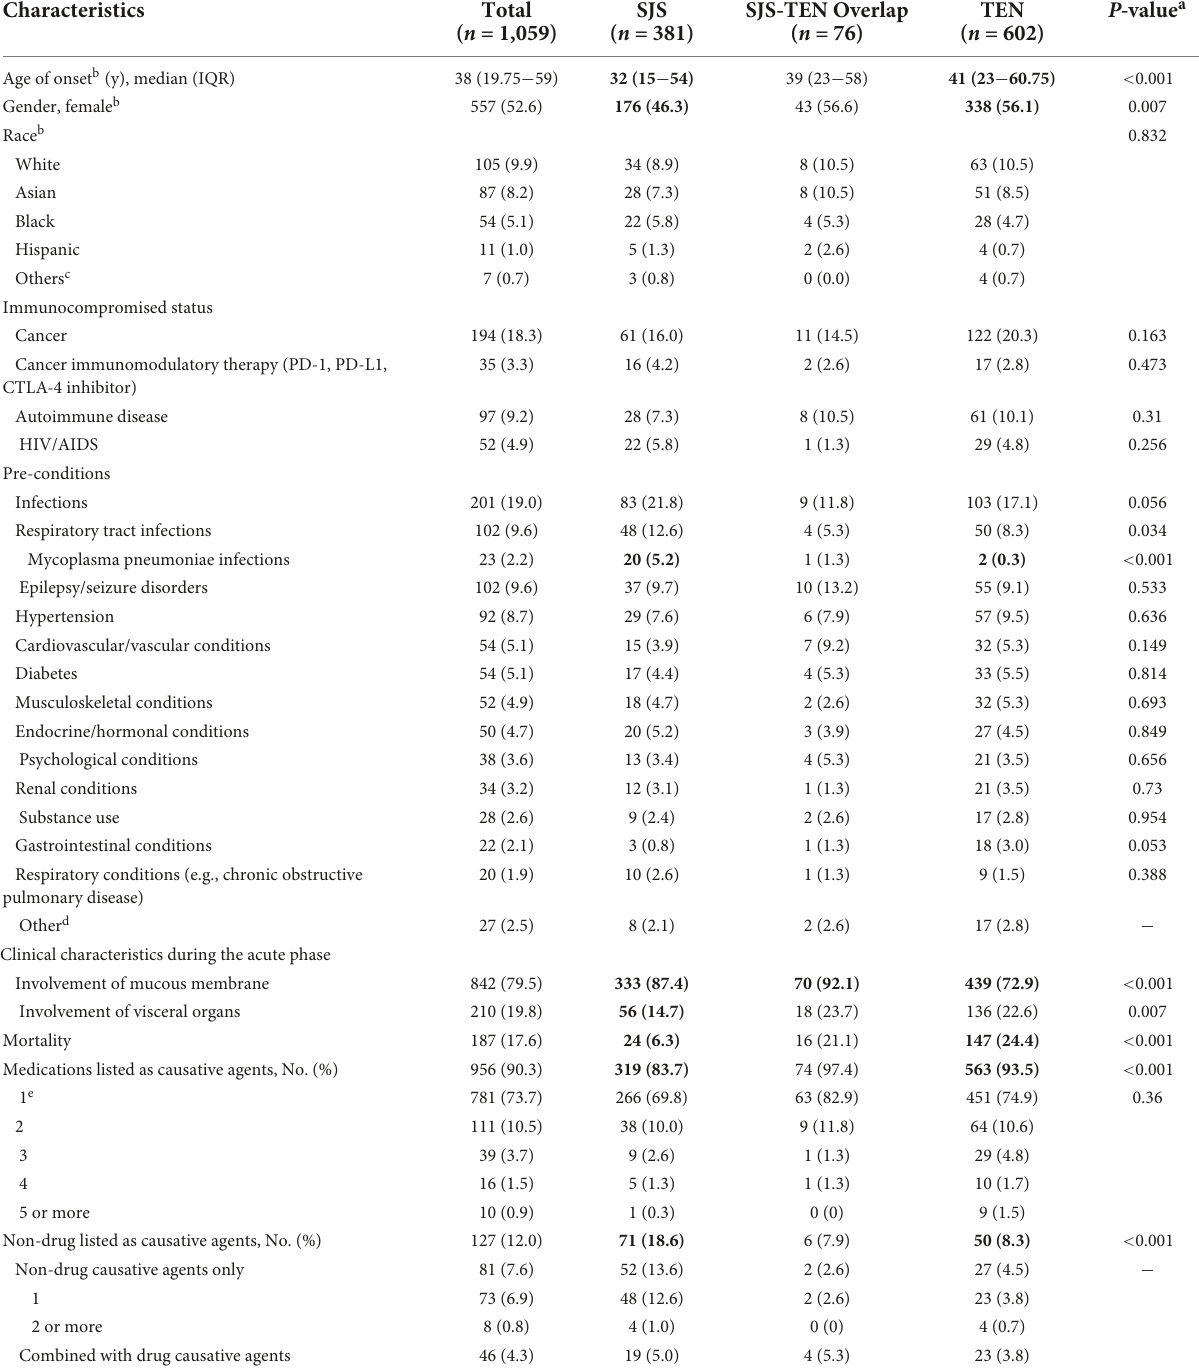
TABLE 3 Demographics and clinical characteristics of Stevens-Johnson syndrome (SJS) and toxic epidermal necrolysis (TEN) cases from PubMed/MEDLINE.